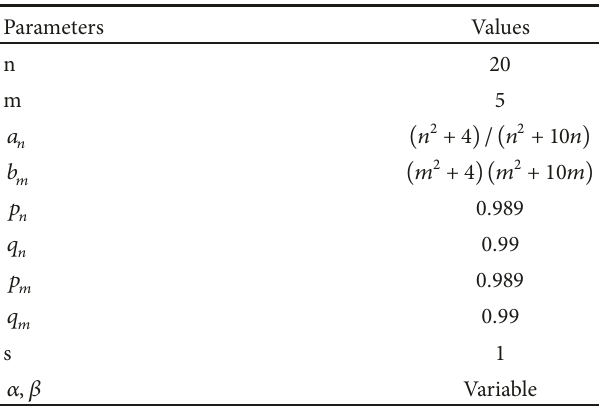
Table 1: 𝐶 analysis.